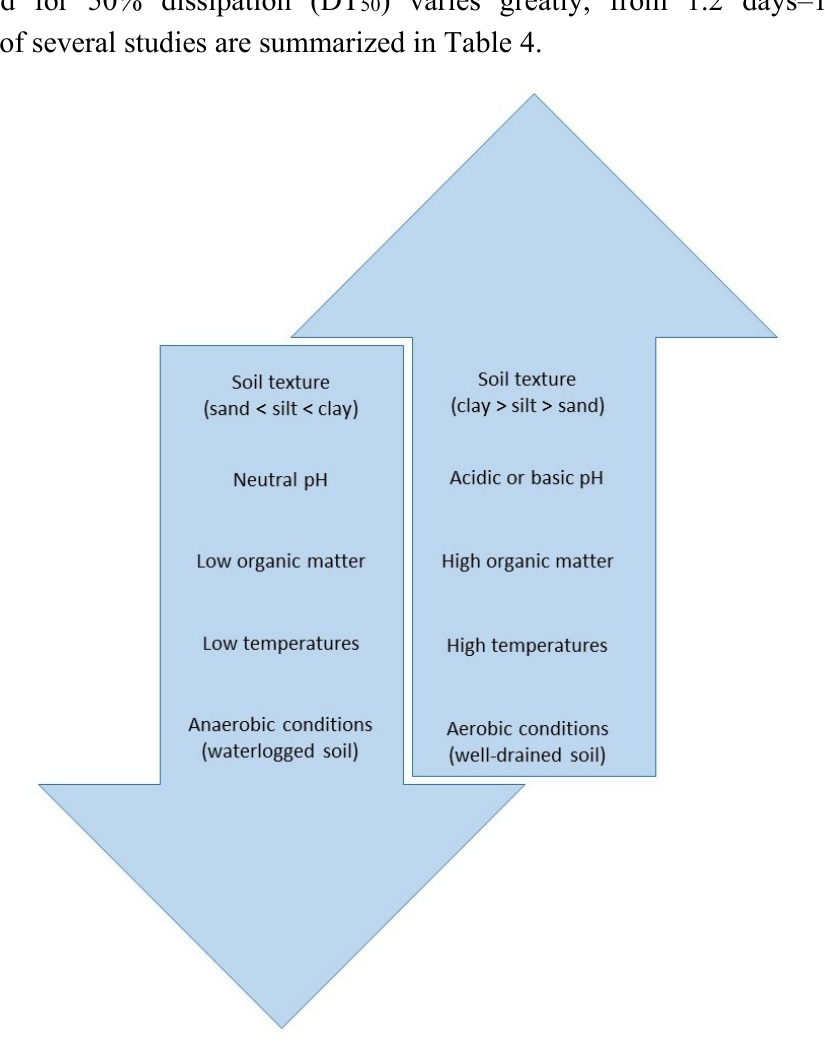
Figure 2. Schematic diagram showing the generalized relationship of environmental factors affecting microbial degradation of glyphosate in soil. Factors listed in the down arrow depress the rate of microbial degradation, while factors listed in the up arrow enhance